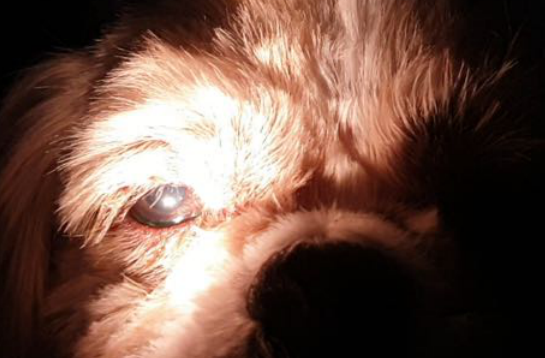
Figure 10 . Assessment of dazzle and pupillary light reflexes (North Downs Specialist Referrals)